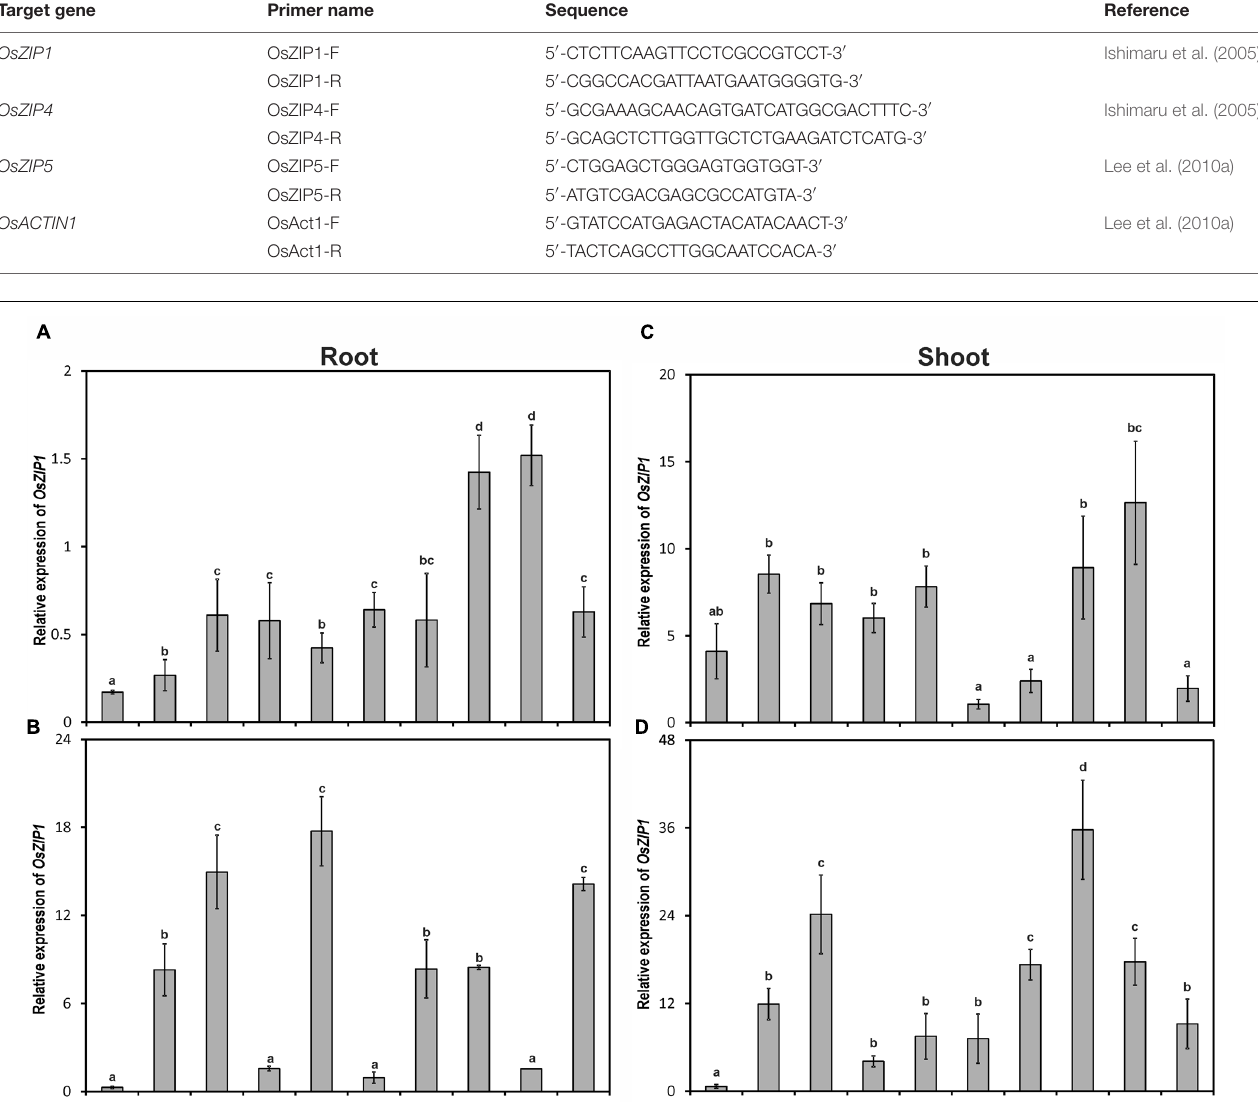
TABLE 1 | Primers used for quantitative real-time reverse transcription PCR.